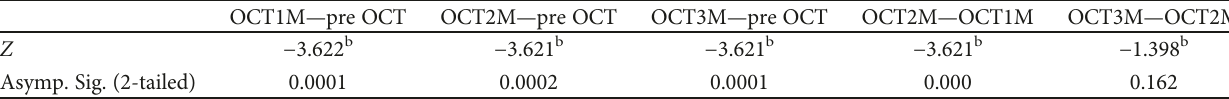
Table 2: Statistical signi fi cance ( p < 0 005 ) in central corneal thickness decreases when comparing the CCT in each visit as compared to the preoperative vision, and when comparing each vision at each visit to the previous visit, except when comparing CCT 3 months postoperatively to the CCT 2 months postoperatively, there is improvement but not statistically signi fi